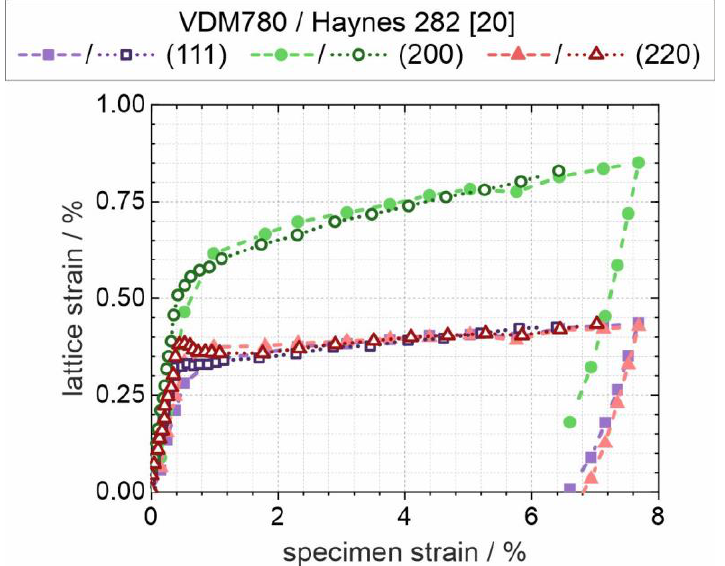
Figure 10. Comparison of the microscopic mechanical properties (lattice strain in different crystal- lographic orientations/specimen strain) of VDM ® Alloy 780 (full symbols) with the literature data of the Ni-based superalloy Haynes ® 282 (open symbols) [20]. The tensile test with Haynes 282 was stopped at a specimen strain of about 6.5%.